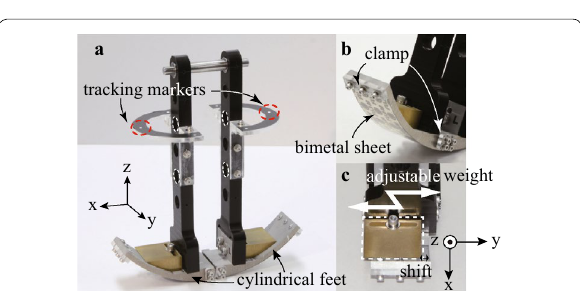
Fig. 10 Experimental prototype. The height of the rotational axis h r and the position of the weight on the feet are